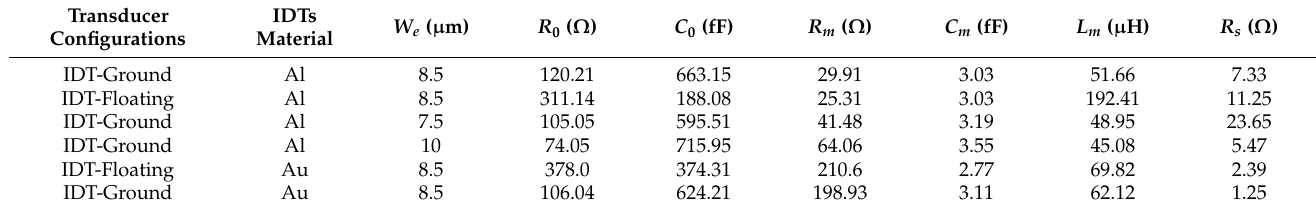
Table 2. The extracted equivalent circuit parameters for the designed LWRs.